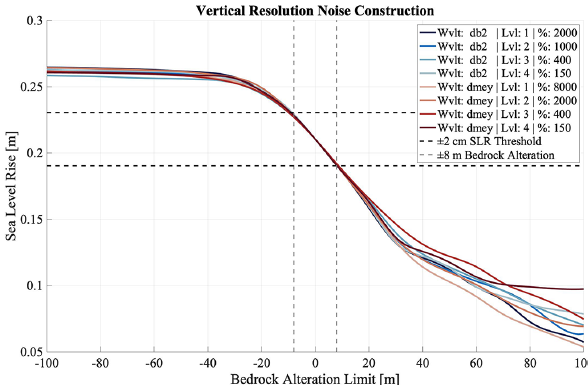
Figure 4. Final SLR plotted against the maximum bedrock change threshold designated for each model simulation. Points repre- sent the model results connected using a spline interpolation. Eight different bedrock topographic realizations are made with high-frequency amplification for this experiment. See Appendix (Sect. A2) for further details on bedrock perturbation codes from the